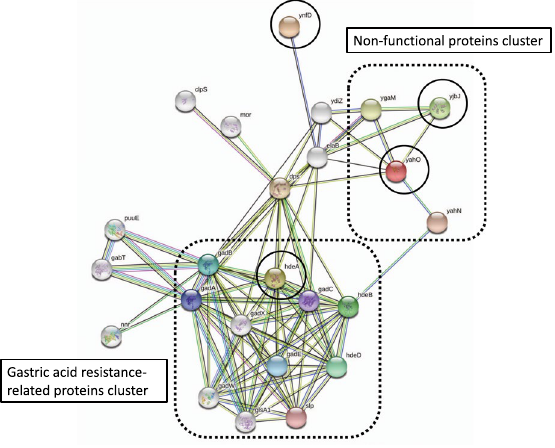
Figure 2. Protein-protein interaction of various proteins predicted using the STRING database (https:// string-db.org). The organism database used Escherichia coli K12 MG1655. The STRING interaction map was generated using default settings (medium confidence of 0.400; criteria for linkages are neighbourhood, gene fusion, co-occurrence, co-expression, experiments, databases and text mining). The circles indicate the coding genes of proteins identified in this study.